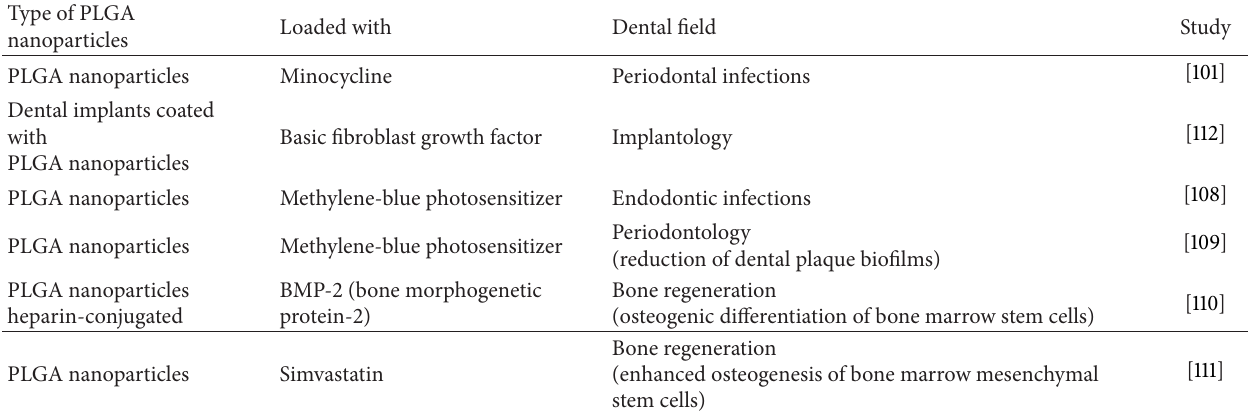
Table 5: Applications of PLGA nanoparticles in dental